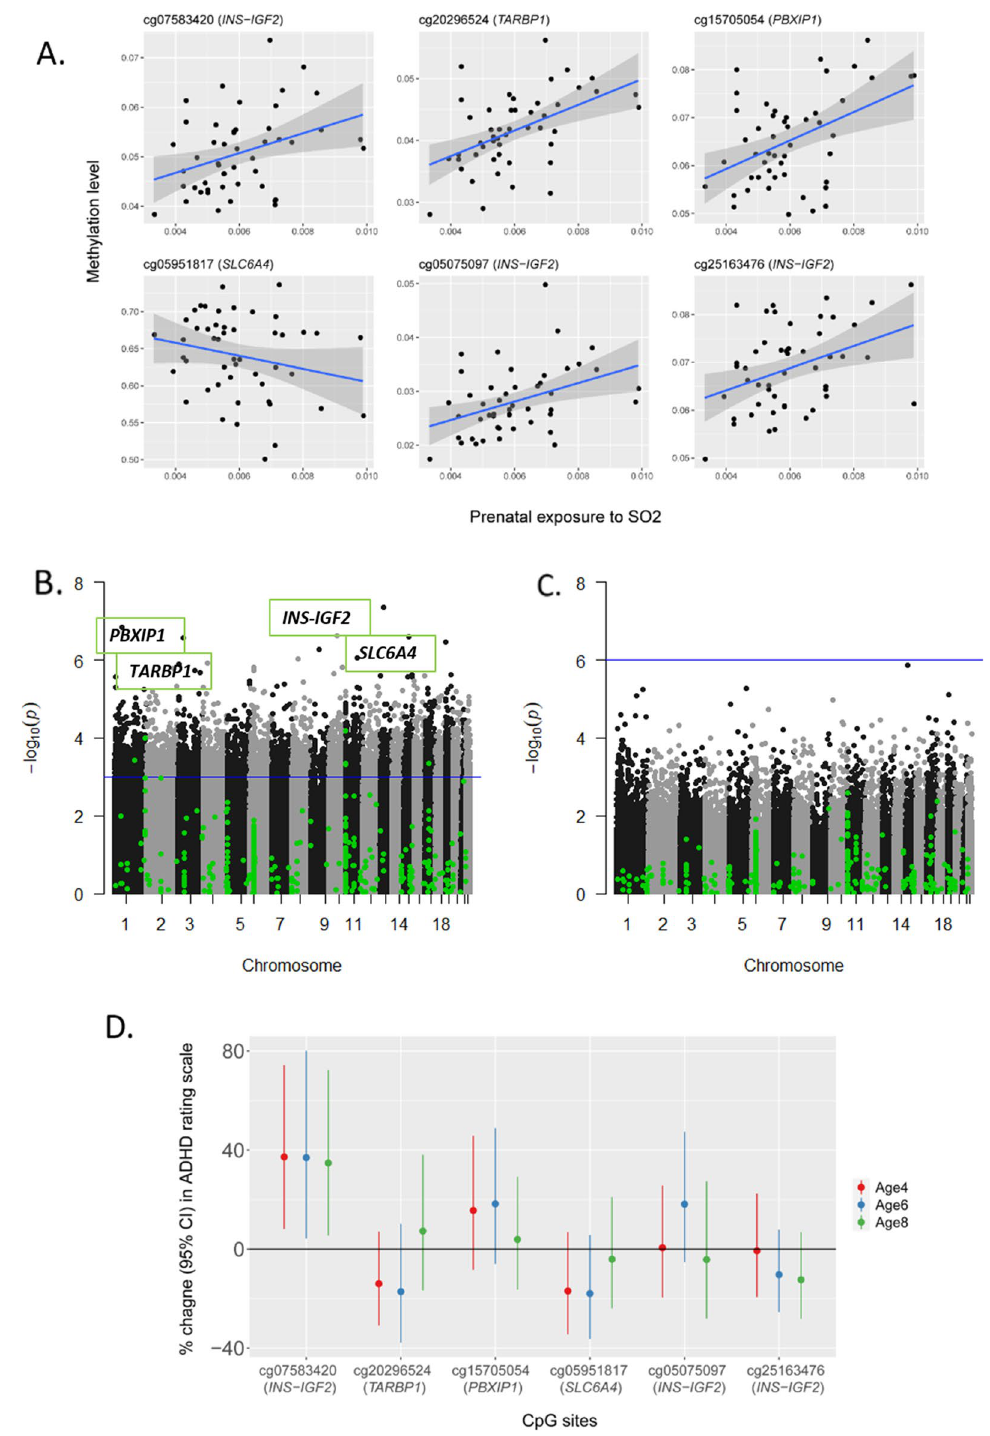
Figure 2. The association between prenatal SO 2 exposure, DNA methylation, and ADHD rating score. ( A ) The association between prenatal SO 2 exopusre and DNA methyhlation. ( B ) Manhattan plot showing the association between prenatal SO 2 exposure during the 3rd trimester and DNA methylation at age 2. The green dots indicate CpGs selected from literature review for a candidate gene analysis. The blue line is the threshold for FDR- corrected p-value < 0.05. The CpGs significantly associated with prenatal SO 2 exposure from the candidate gene analysis were above the threshold line (cg07583420 ( INS-IGF2 ), cg20296524 ( TARBP1 ), cg15705054 ( PBXIP1 ), cg05075097 ( INS-IGF2 ), and cg25163476 ( INS-IGF2 )). ( C ) Manhattan plot showing the association between prenatal SO 2 exposure during the 3rd trimester and DNA methylation at age 6. ( D ) The association between DNA methylation at the CpGs linked with prenatal SO 2 exposure and the ADHD rating scale at ages 4, 6 and